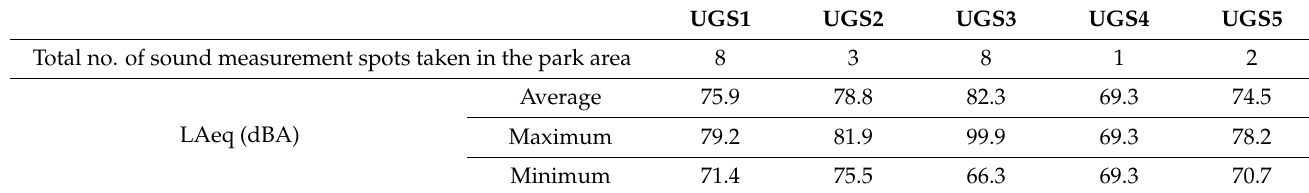
Table 4. The arithmetic average of the sound pressure level (LAeq) in the different UGSs. UGS1